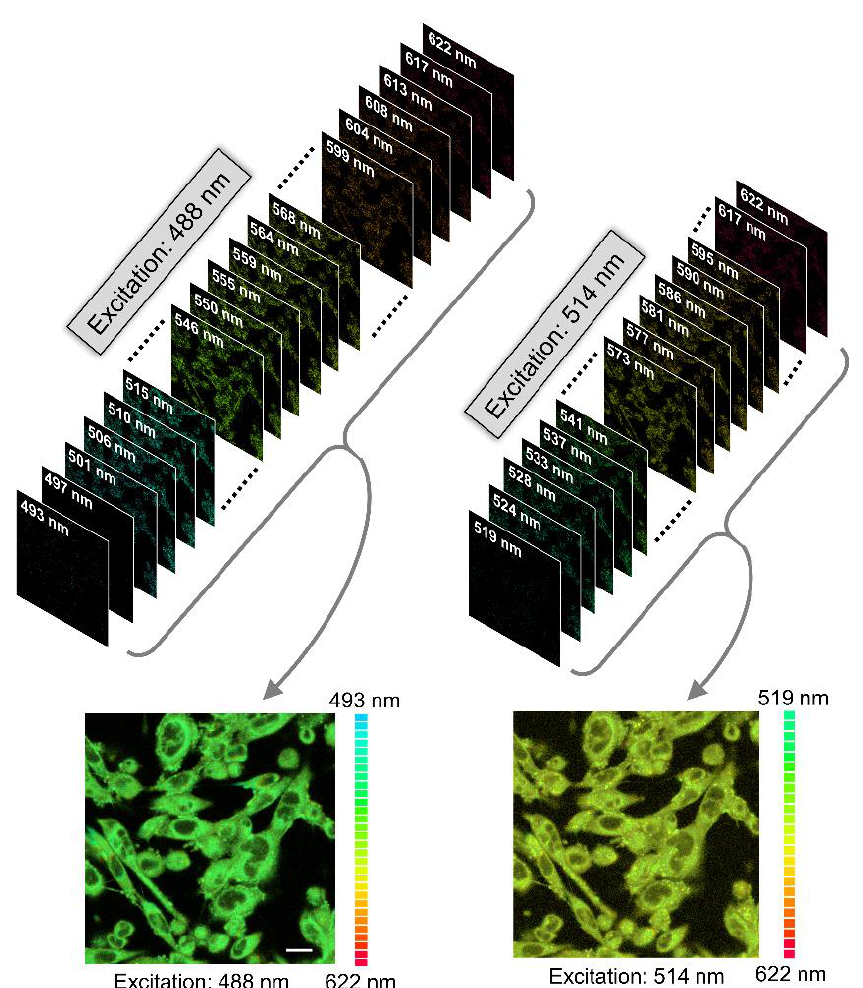
Figure 6. Spectral image stacks consisting of a collection of images showing serotonin 1A receptor labeled using NBD-serotonin analog I, each of which measured at a specific wavelength (highlighted on top left corner of image) for two different excitation wavelengths. Unlike a typical confocal image, which is acquired over a wavelength range of the detector, a spectral image contains a collection of images of the same field captured at different wavelengths. As a result, spectral images provide a complete emission spectrum of the fluorophore at every pixel location. The corresponding overlaid image of the linearly unmixed spectral image stack is shown at the bottom. The individual images in the stack were colored according to the color-map showed beside the overlaid image. Note that the overall red-shifted emission of the NBD-serotonin analog I when excited at the red edge (514 nm) indicates REES. The scale bar represents 10 µ m. See Materials and Methods for other details.